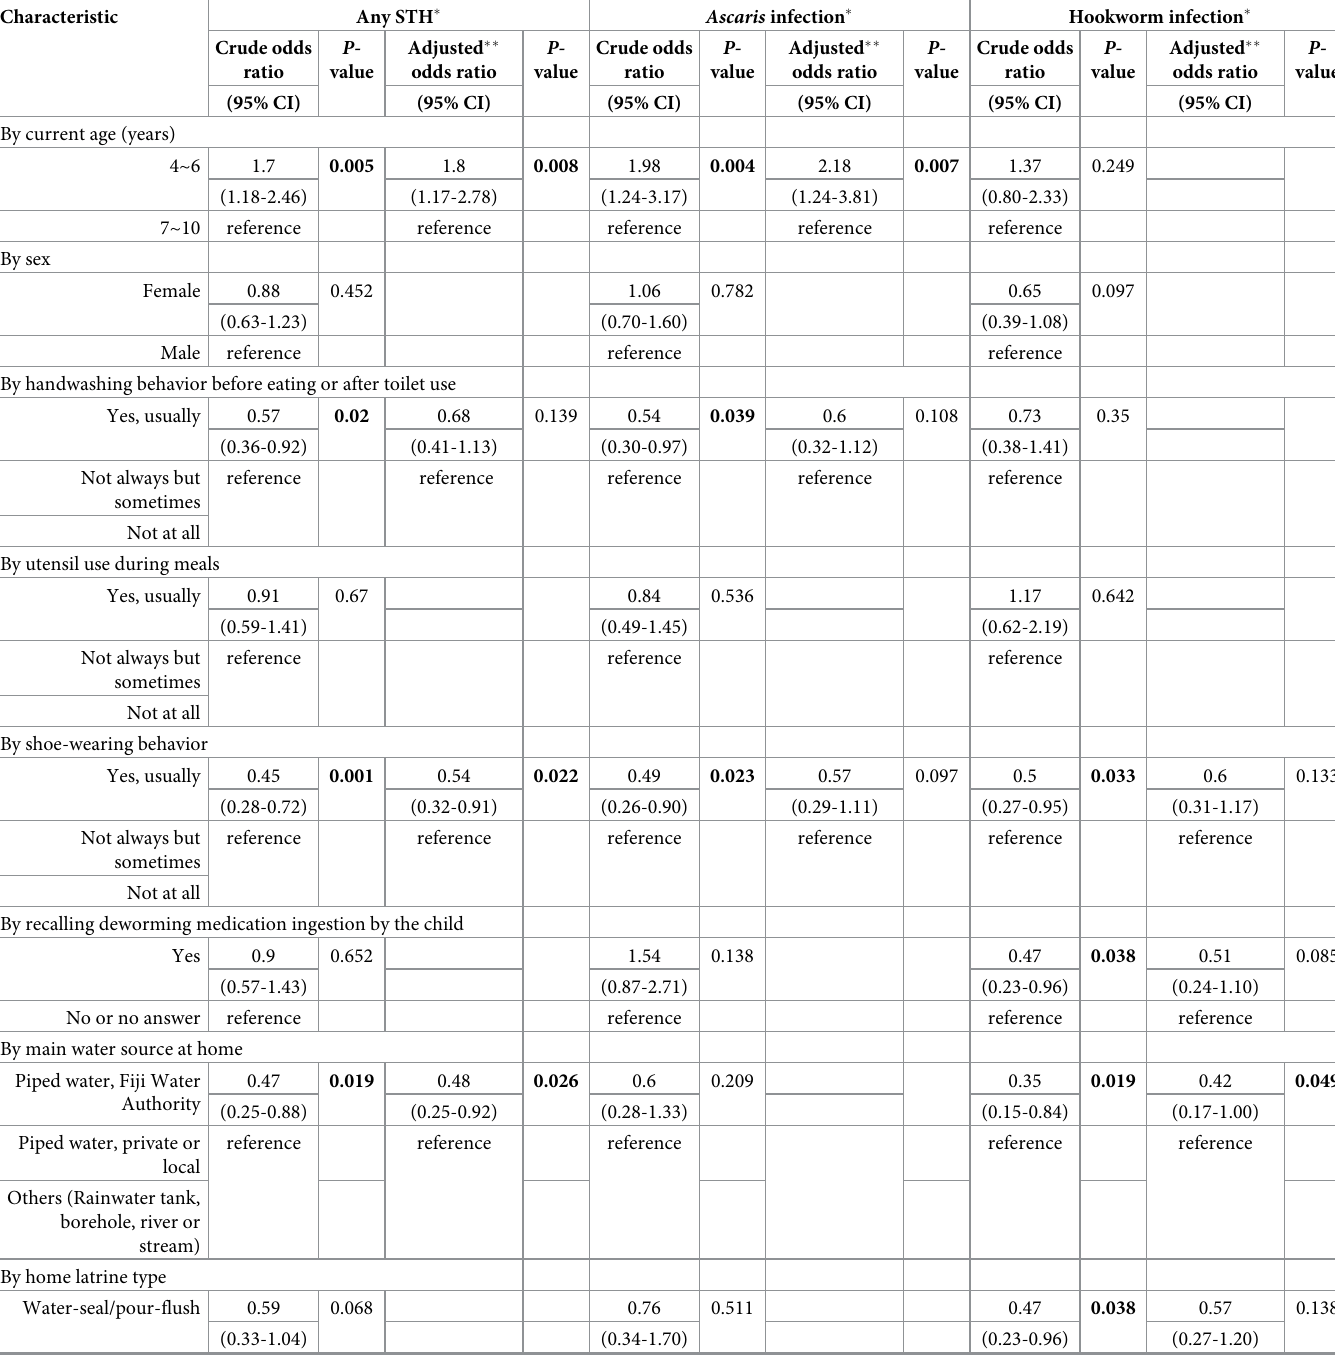
Table 6. Associations between students’ demographic and WASH characteristics and STH prevalence levels by species.